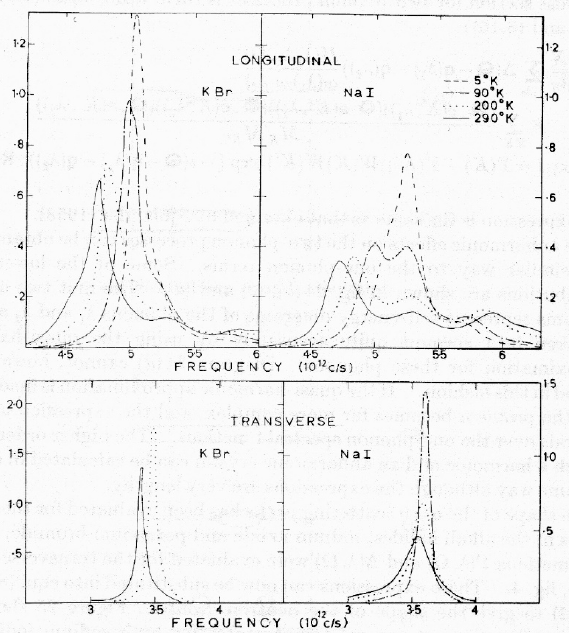
Figure 28. The calculated shapes of the inelastic scattering peaks from the q = 0 longitudinal and transverse optical modes in potassium bromide and sodium iodide at several temperatures. The intensity is in arbitrary units. The figure is taken from Figure 25 of ref. [74] on anharmonicity in the alkali halides courtesy of Taylor and Francis.